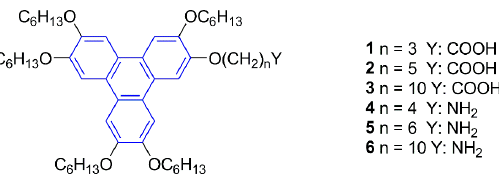
Figure 1. Structures of triphenylene derivatives 1 – 6 . The triphenylene core is shown in